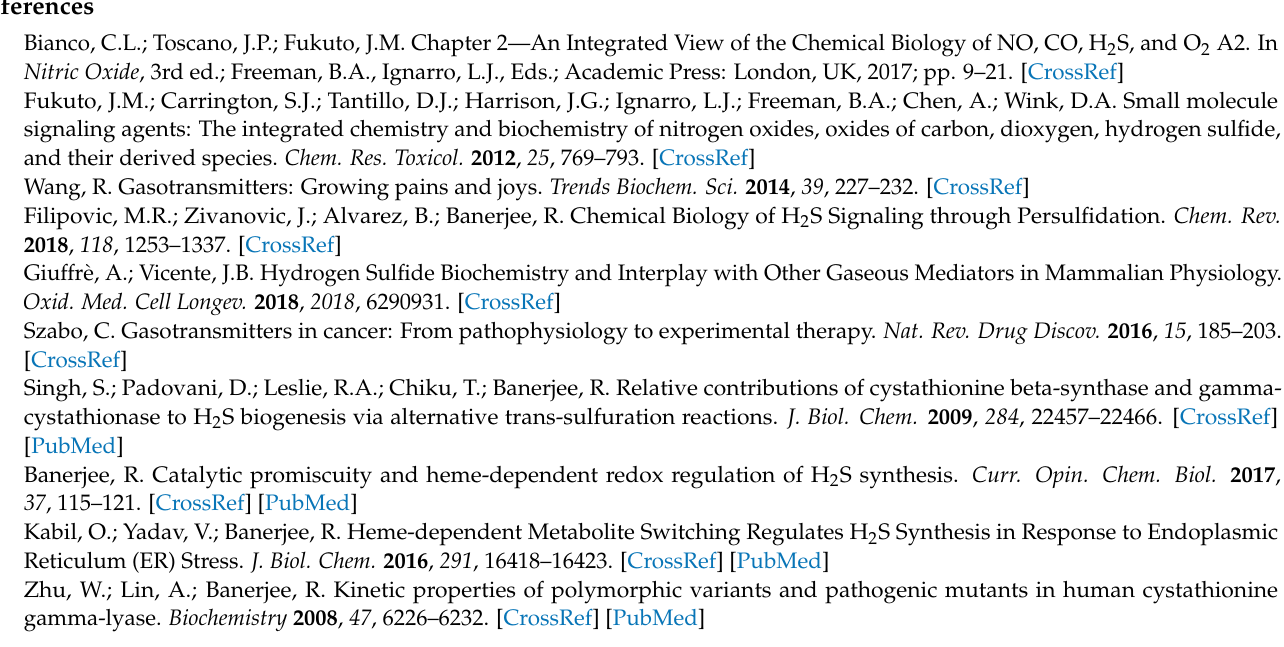
CSE; Figure S12: Structural flexibility of CSE; Figure S13: Sequence alignment of CSE homologues; Supplementary Table S1: Assessment of cysteine surface accessibility; Sequences of CSE variants inserted in pET28b between the NcoI and BamHI sites (underlined in each